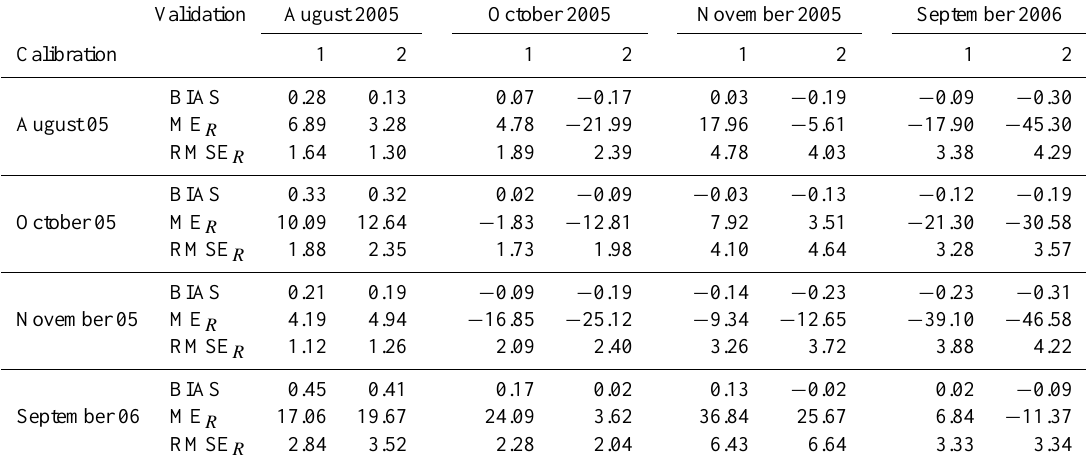
Table 2. Validation results for the eight Z/R relationships in each of the four study cases. The numbers in the second row represent the pdf fitting method, being 1 exponential-Gamma and 2 for the Kernel smoothing density